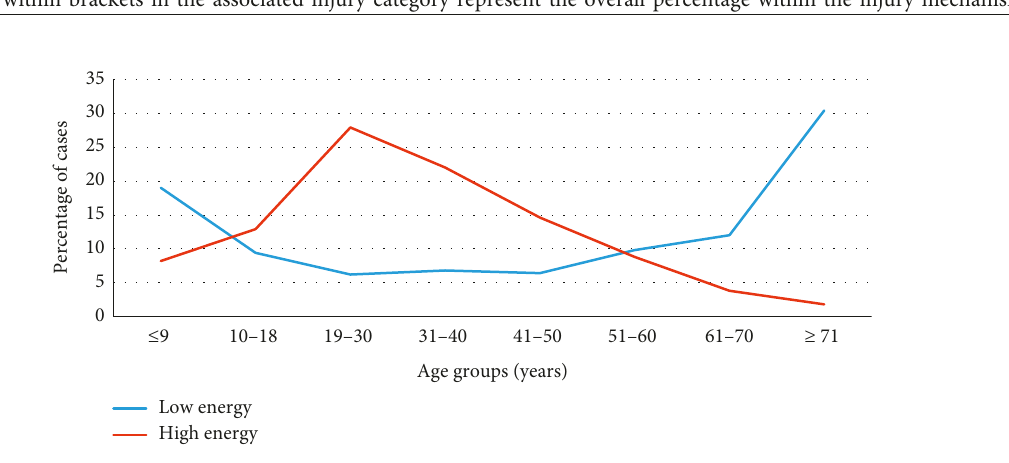
Figure 2: Comparison between high- versus low-energy injuries across age